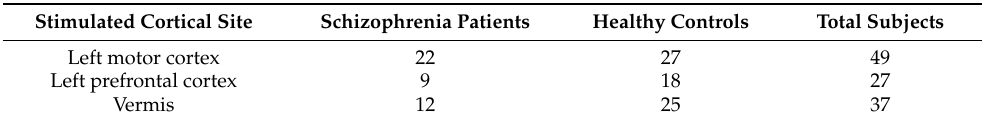
Figure 1. EEG data recording in response to TMS are preprocessed for artifact removal and ERP extraction. Scalp ERP is processed for cortical source localization. Then, machine learning analysis of localized cortical source current density values is done to get brain region network energy values. Statistical analysis of the obtained brain network energies is performed for the patients and healthy control groups to select the relevant extracted signature for plausible clinical application. Table 1. Summary of subjects counted for gathered EEG data from three stimulated cortical sites by TMS subthreshold pulse.